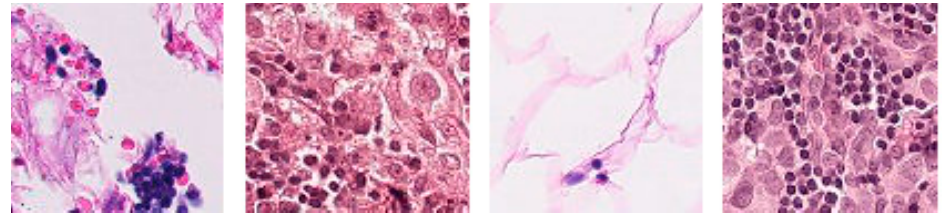
Figure 9. A sample of the PatchCamelyon dataset.